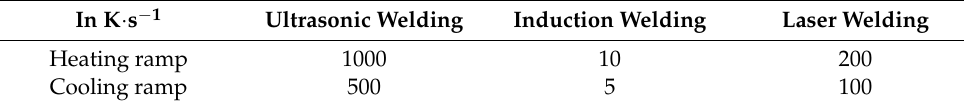
Table 1. Heating and cooling temperature ramps for welding processes